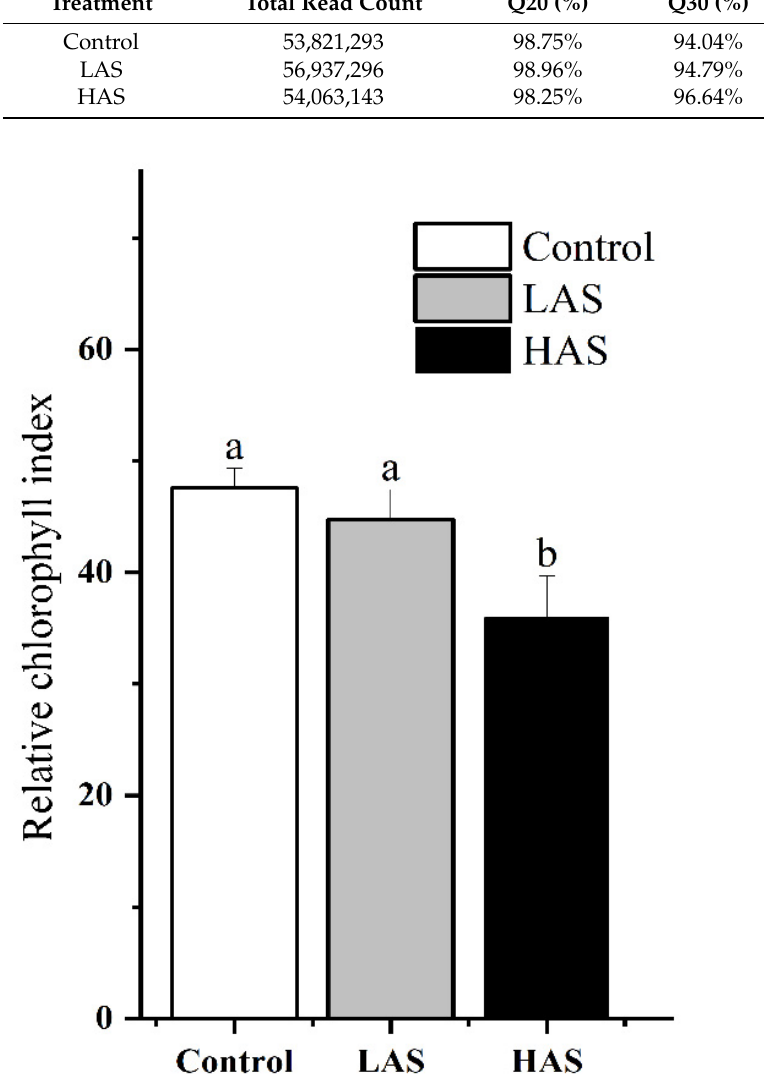
Figure 1. The effect of different concentration alkali stress on the leaf relative chlorophyll index of M. cerifera . Control, alkali stress control group; LAS, low-concentration alkali stress treatment group of M. cerifera ; HAS, high-concentration alkali stress treatment group of M. cerifera . Significant differences ( p < 0.05) were indicated by different lowercase letters according to the one-way ANOVA followed by a Duncan’s test.